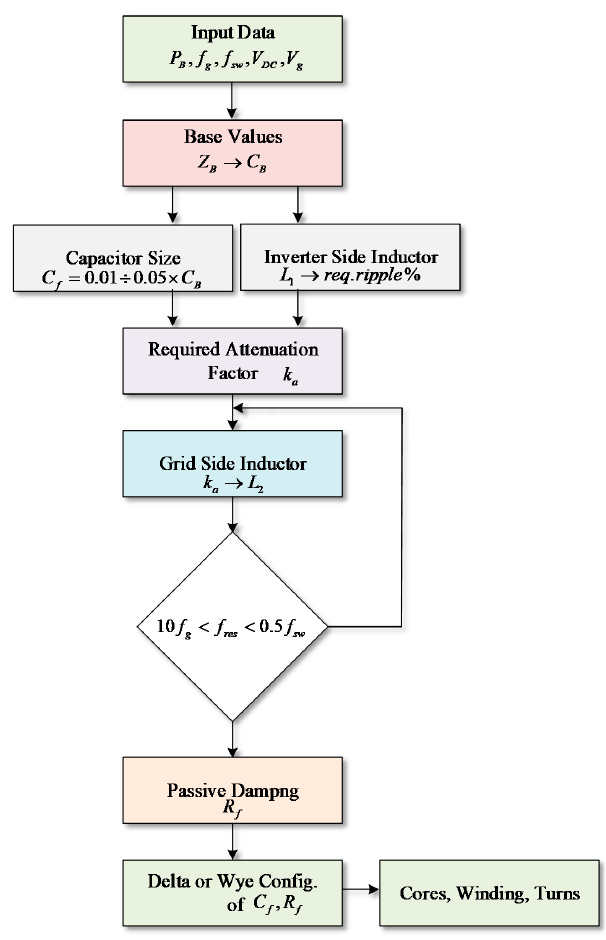
Figure 9. LCL filter design algorithm.